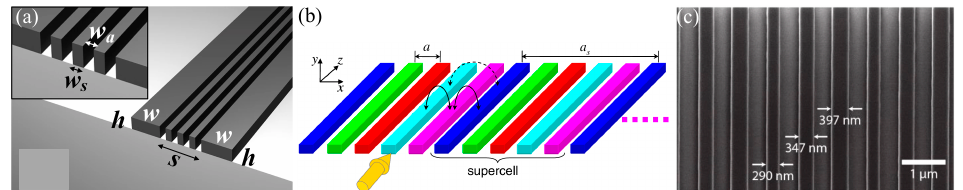
Figure 12. Some optical crosstalk-suppressed structures. ( a ) The configuration of Si waveguide pair with an inserted periodic Si strip array. Reproduced from [131] published by Springer Nature, 2017. ( b ) Schematic of waveguide superlattice structures. Reprinted with permission from [134] © 2020 Chinese Laser Press. ( c ) Top-view SEM of an OPA with varying waveguide widths for minimizing overlaps in phase space. Reprinted with permission from the author of [94] published on Arxiv, 2018.